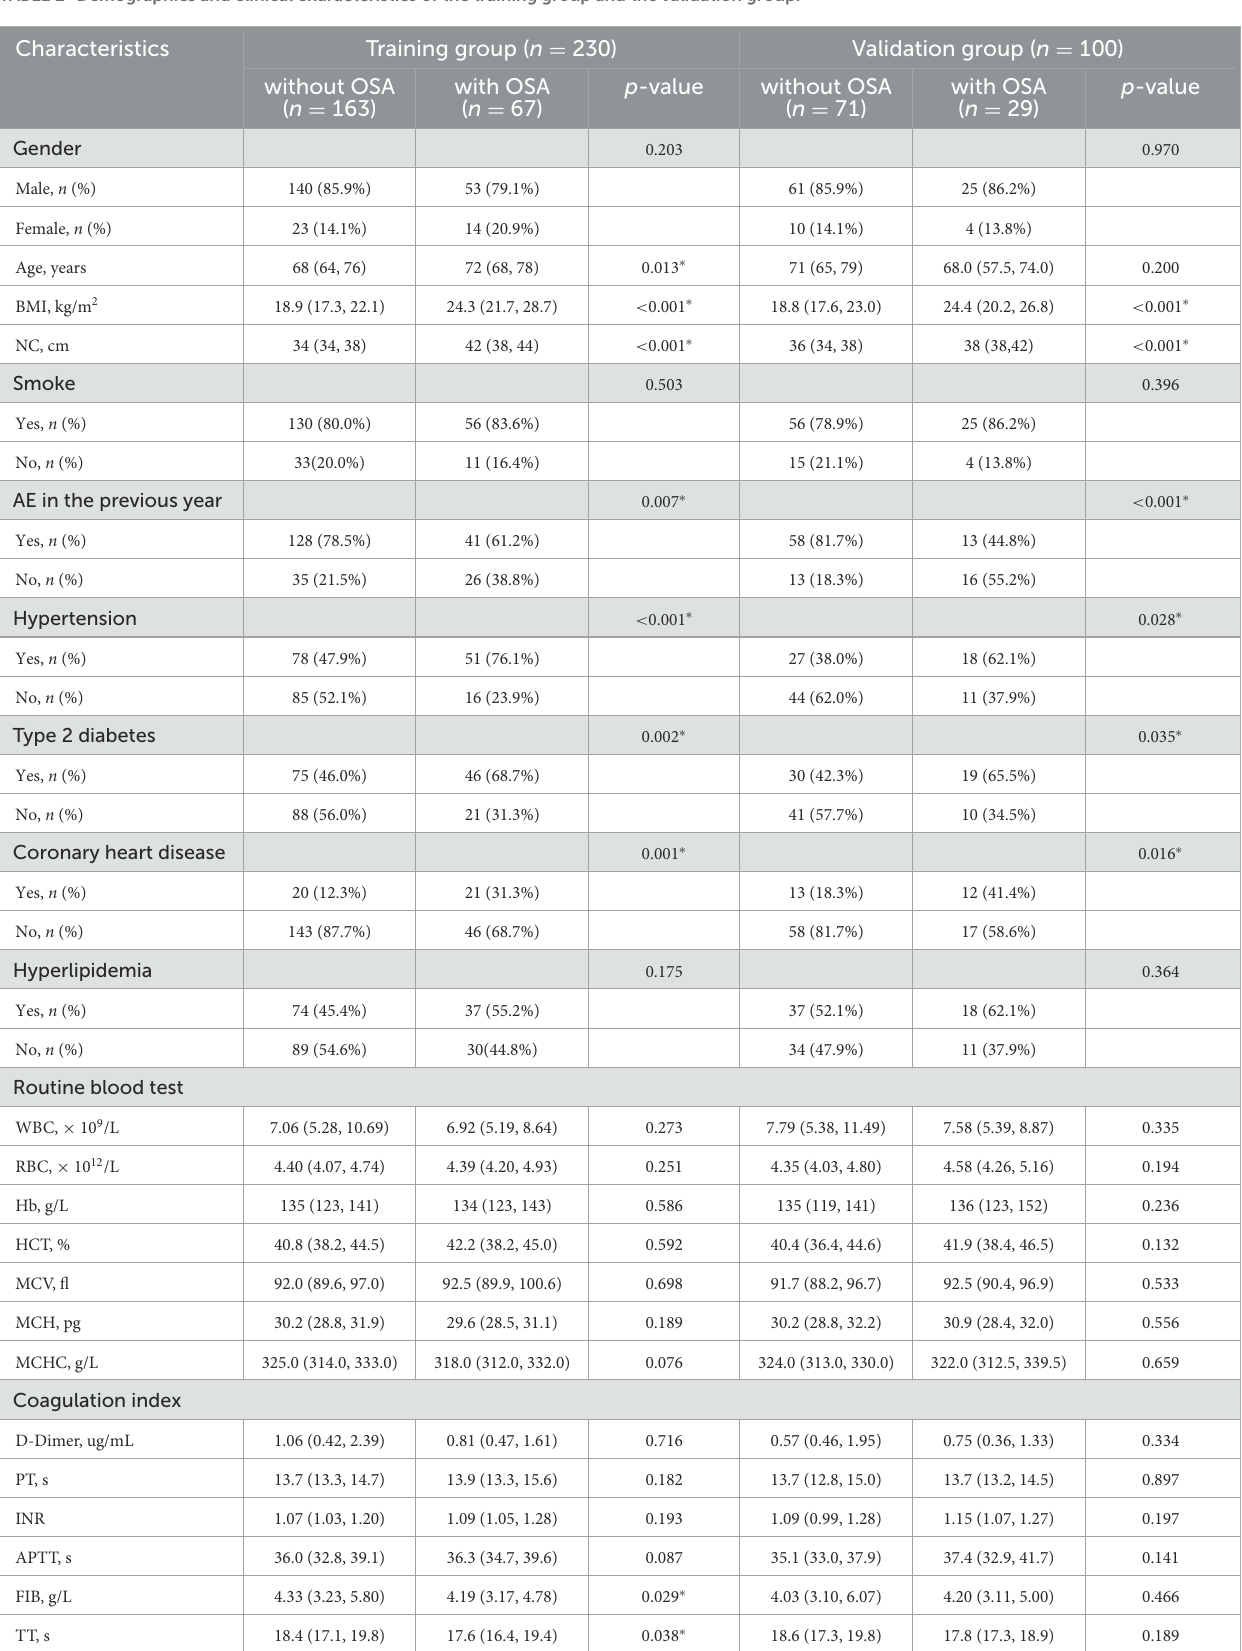
TABLE 2 Demographics and clinical characteristics of the training group and the validation group.